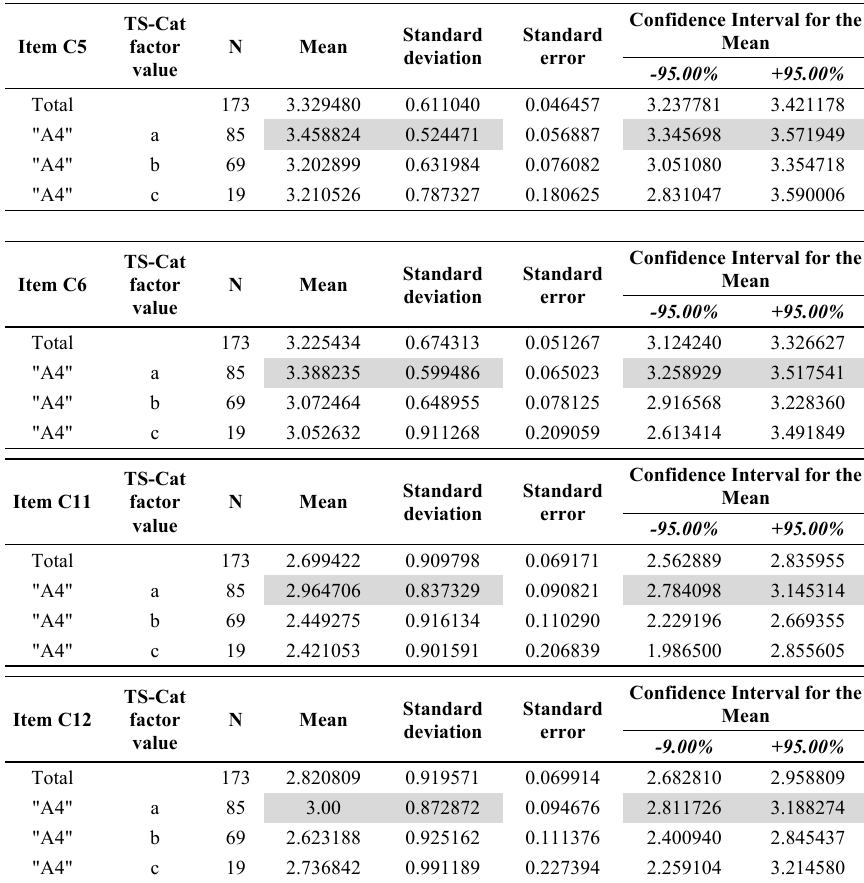
Table 2. Descriptive statistics of the items C5, C6, C11 and C12 of the questionnaire part